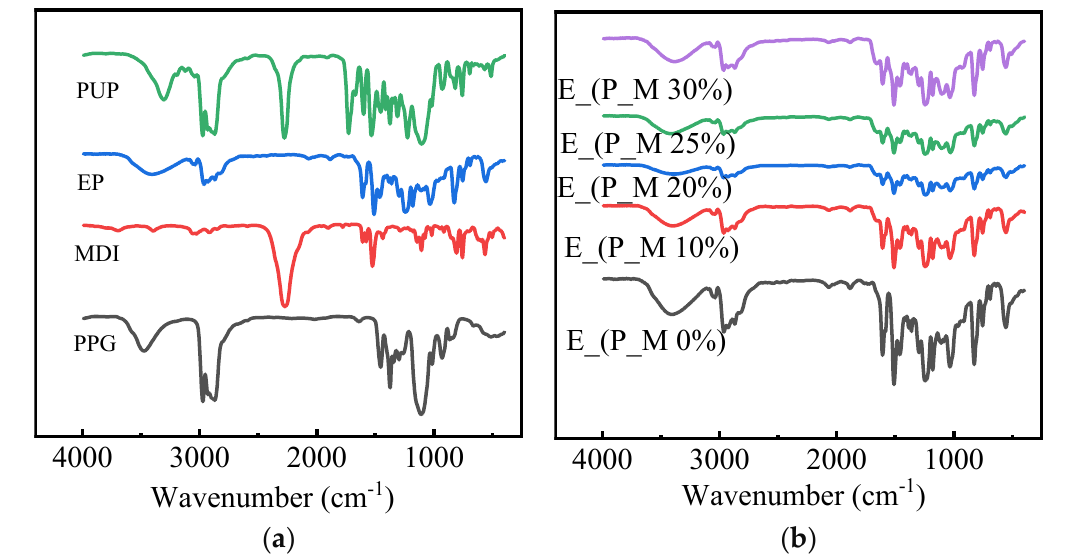
Figure 2. FT-IR spectra of modifying agents and E-(P-M X%). ( a ) Modifiers and pure EP, ( b ) Modified Epoxy Resin.